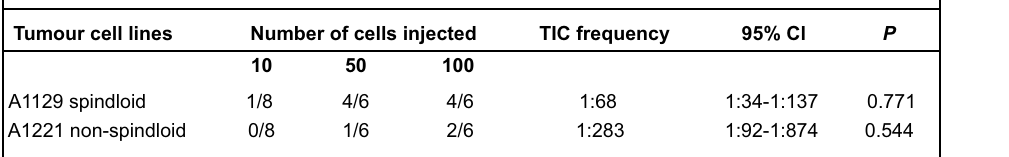
Fig. 1 MMTV- Met mt ;Trp53 fl / + ; Cre spindloid tumour-derived cells have higher sphere-forming ef fi ciencies (SFE) than non-spindloid cells. a Representative image of MMTV- Met mt ;Trp53 fl / + ; Cre spindloid cell lines A1005 and A1129 and adenocarcinoma (non-spindloid) cell lines A1221 and A1222 in adherent culture are shown (top). The proliferative rates of the spindloid (A1005, A1129) and non-spindloid (A1221, A1222) cell lines were assessed for 96 h by Trypan blue assay (bottom) ( n = 3). b Representative images of tumourspheres formed from MMTV- Met mt ;Trp53 fl / + ; Cre tumour cell lines (top). Tumourspheres were assessed on day 5 for quantity and size using AxioVision (Carl Zeiss) (bottom). Scale bar: 100 μ m ( n = 3). c Cells were injected into the mammary fat pads of female athymic mice at the indicated numbers. Tumour-initiating capacity was calculated using Extreme Limiting Dilution Analysis online software (http://bioinf.wehi.edu.au/software/elda/) 12.5 weeks post- inoculation (10 injected cells ( n = 8); 50 injected cells ( n = 6); 100 injected cells ( n = 6)). Student ’ s t test; * P ≤ 0.05; ** P ≤ 0.01; *** P ≤ 0.001; **** P ≤ 0.0001. Error bars indicate